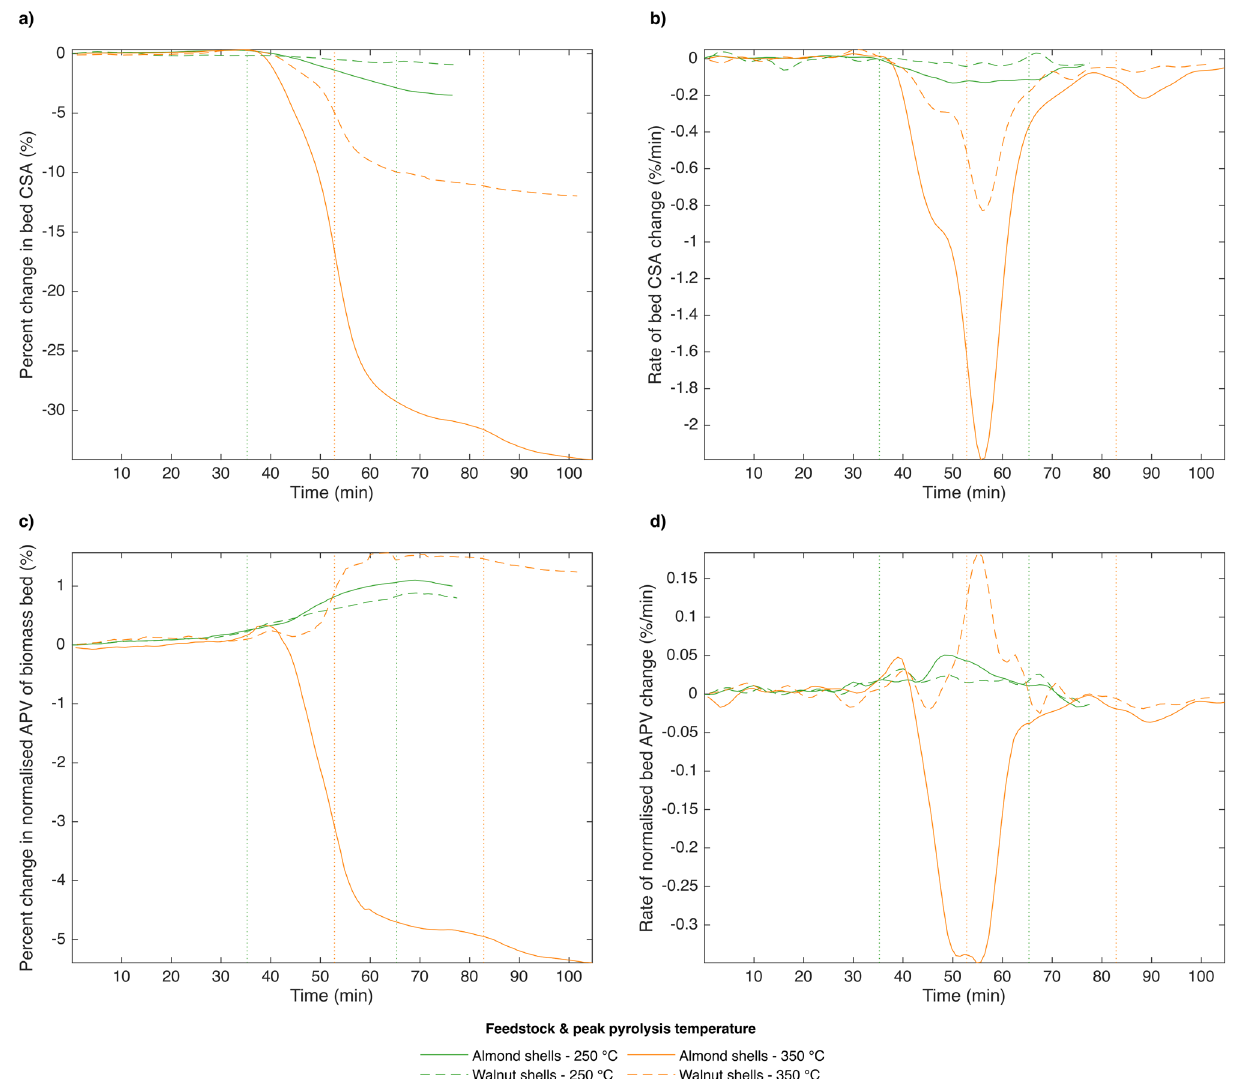
Figure 2. Evolution of cross-sectional area (CSA) and normalized average pixel value (APV) of untreated biomass beds by feedstock and peak pyrolysis temperature. APV of the biomass bed is temporally normalised by that of the cell void space. Samples were pyrolysed by a 3 L min −1 stream of pre-heated argon at a rate of 6 °C min −1 , followed by a 30-min hold time at peak temperature. Vertical lines indicate the start and end of the 30-min hold time. ( a ) CSA. ( b ) d(CSA)/dt. ( c ) APV. ( d )